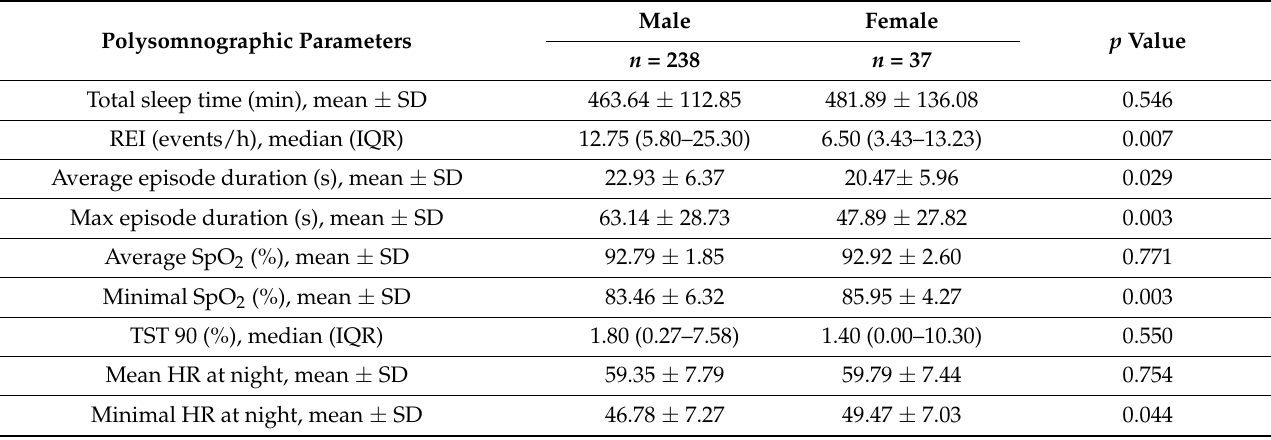
Table 3. Characteristics of polysomnographic parameters in men and women with obstructive sleep